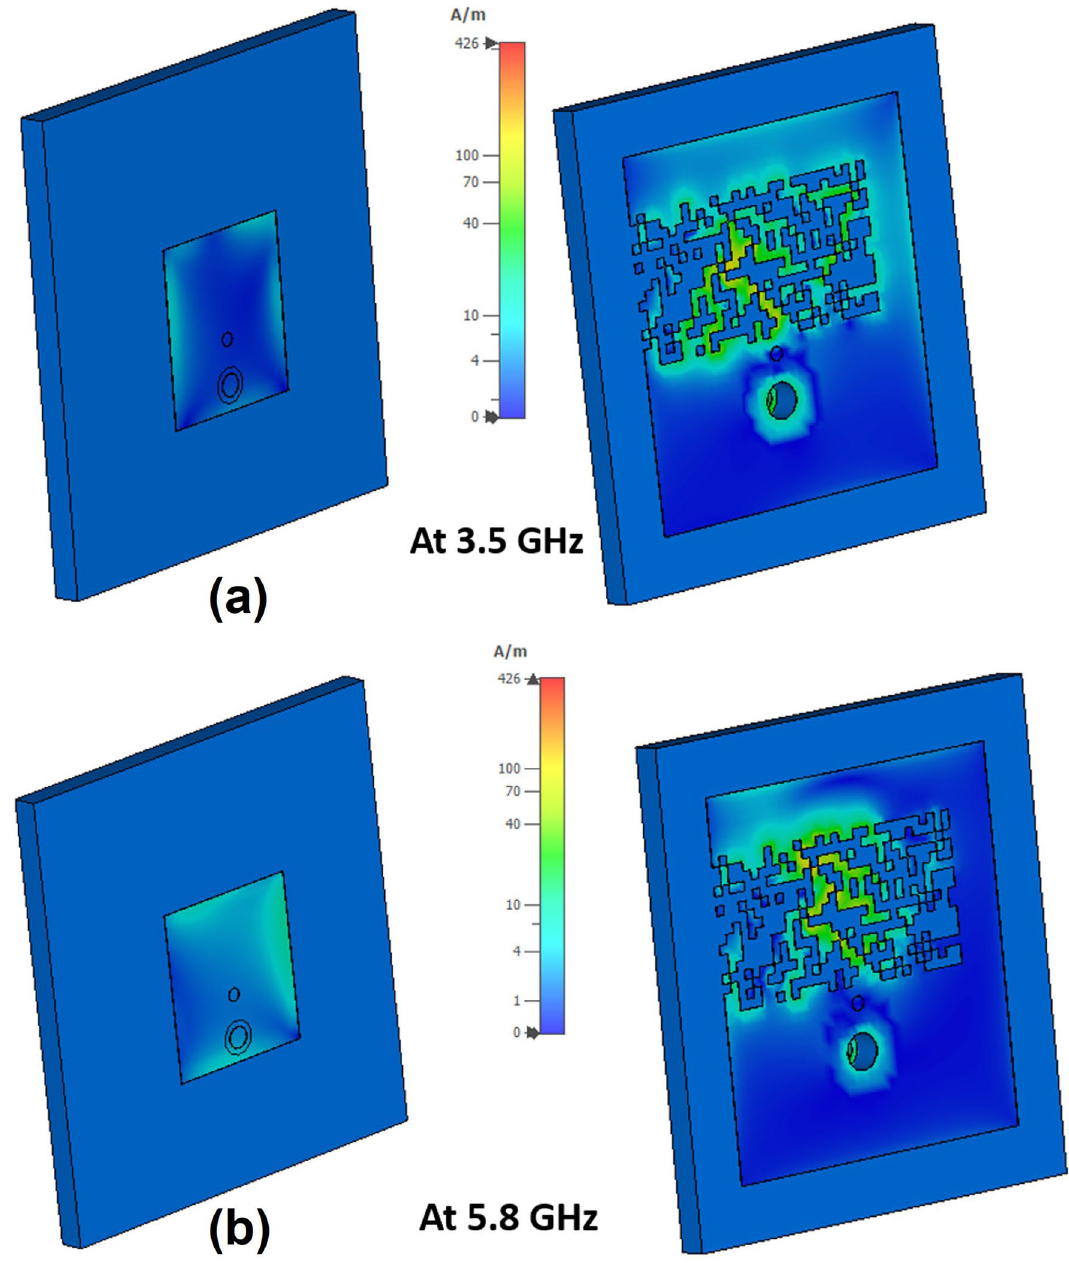
Figure 14. Surface current distribution of the antenna, Software used: CST Microwave Studio